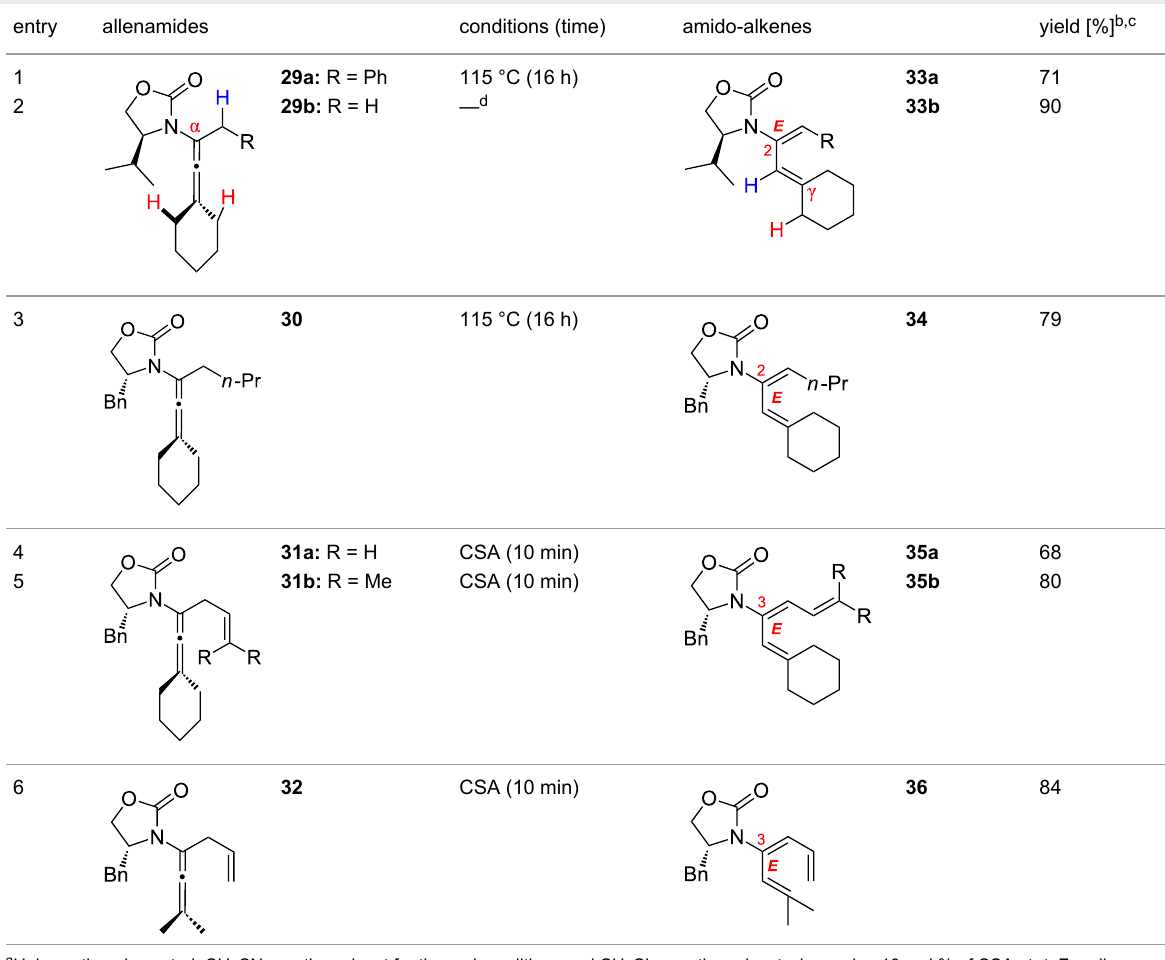
Table 4: A regioselective 1,3-hydrogen shift. a